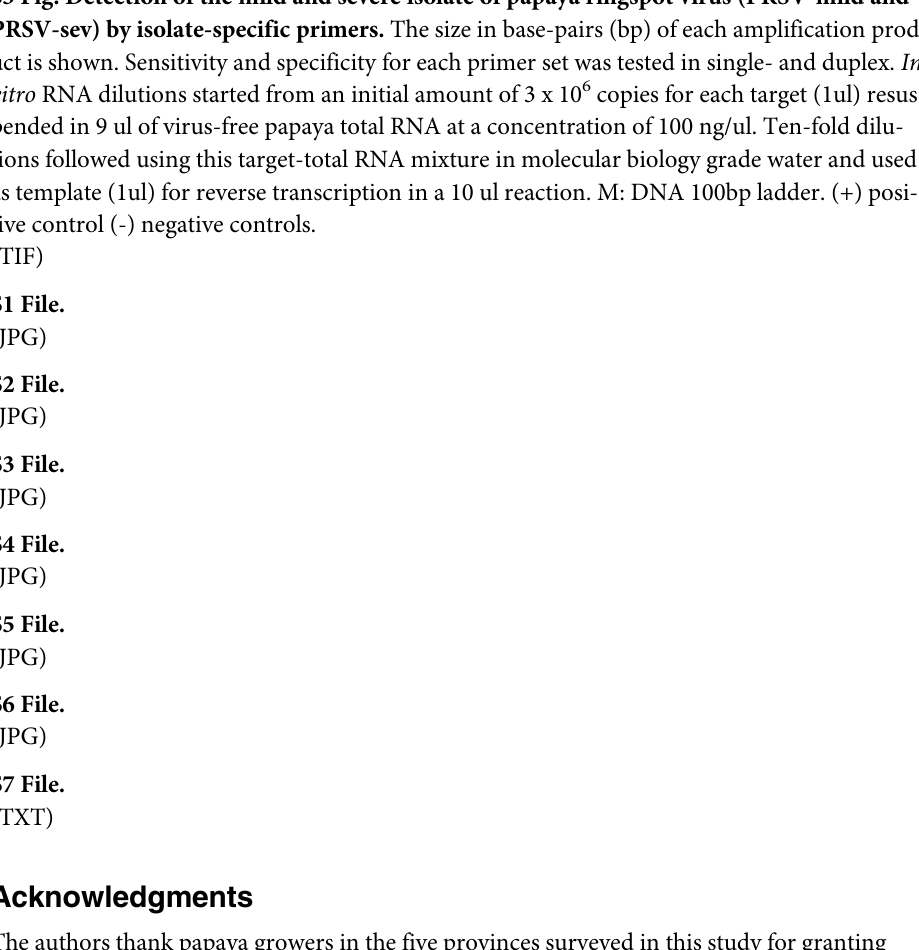
S3 Fig. Detection of the mild and severe isolate of papaya ringspot virus (PRSV-mild and PRSV-sev) by isolate-specific primers. The size in base-pairs (bp) of each amplification prod- uct is shown. Sensitivity and specificity for each primer set was tested in single- and duplex. In vitro RNA dilutions started from an initial amount of 3 x 10 6 copies for each target (1ul) resus- pended in 9 ul of virus-free papaya total RNA at a concentration of 100 ng/ul. Ten-fold dilu- tions followed using this target-total RNA mixture in molecular biology grade water and used as template (1ul) for reverse transcription in a 10 ul reaction. M: DNA 100bp ladder. (+) posi- tive control (-) negative